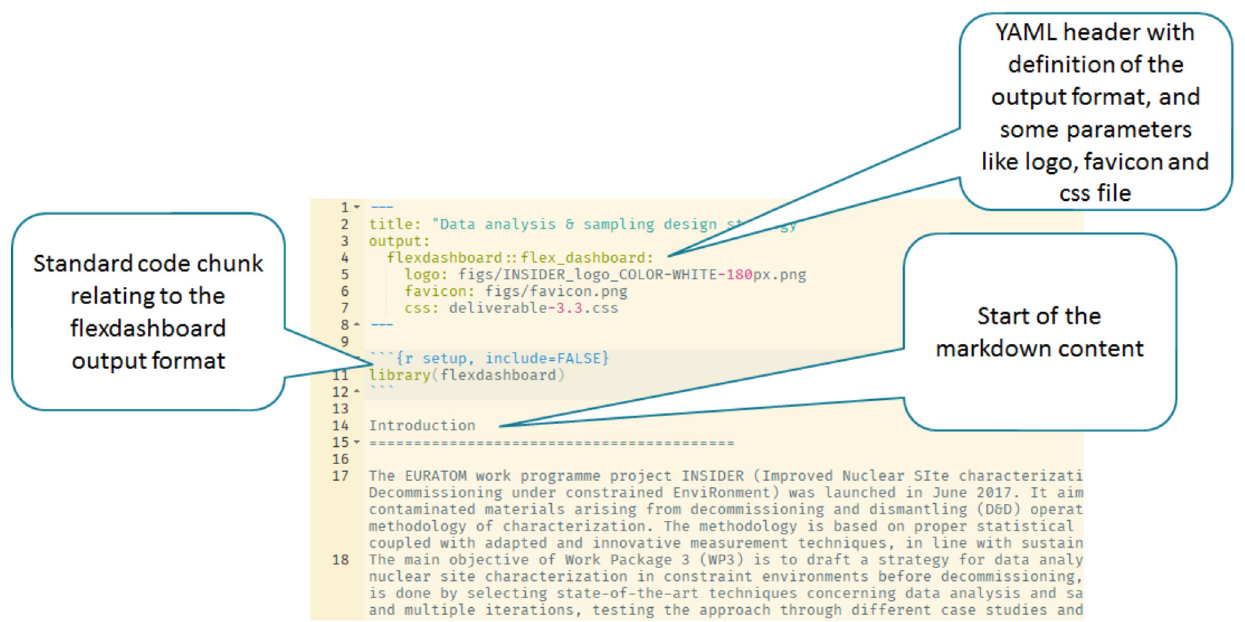
Fig. 6. Main *.Rmd fi